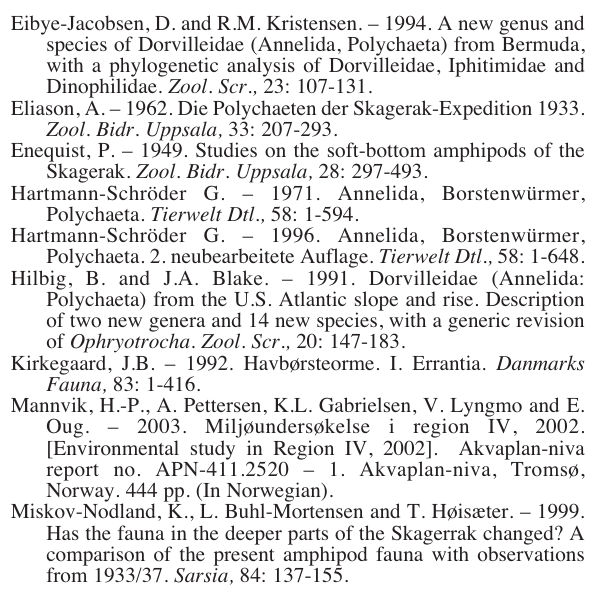
(Fig. 2D) composed of two anteriorly-flared rods, each with a marked tooth on inner border of anteri- or margin. Mandibles have a process on left piece fitting into a socket on right piece. Several more or less irregular hook-shaped or globular processes sit- uated posteriorly on the rods. Maxillae (Fig. 2E) of p-type, composed of the forceps and anterior denti- cles in two rows on each side. Prongs of forceps with anterior hook and inner cutting edge with 6-8 teeth. Medially on prongs a raised ridge with about 6 teeth. Seven free denticles on each side, outer row denticles with a strong tooth and serrated inner mar- gin, inner row denticles with fine teeth along inner margin. Sexual products (eggs) observed in middle and posterior chaetigers in some specimens (holo- type,